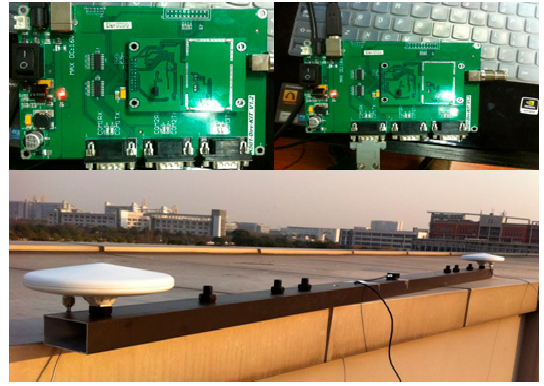
Figure 10. Receiver electric circuit and antennae configuration.